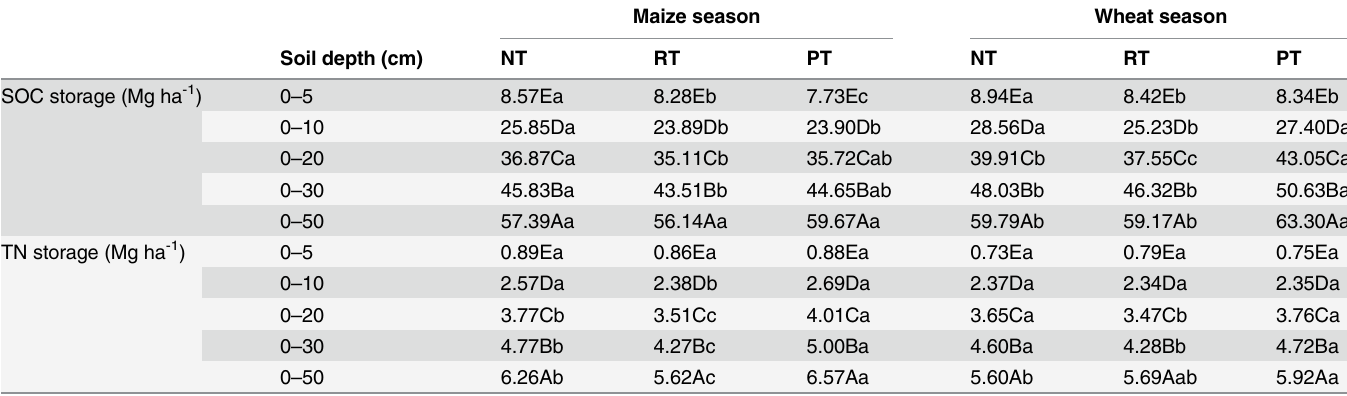
Table 2. Storage of the soil organic carbon (SOC) and total nitrogen (TN) for the wheat and maize